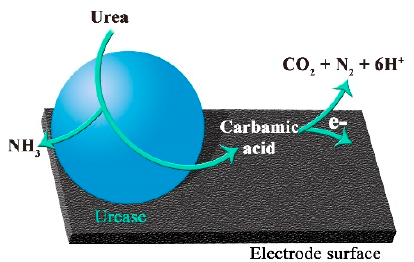
Figure 2. The principle of direct carbamic acid oxidation on carbonaceous nanomaterials’ surface, E = 0.2 V vs. Ag/AgCl.